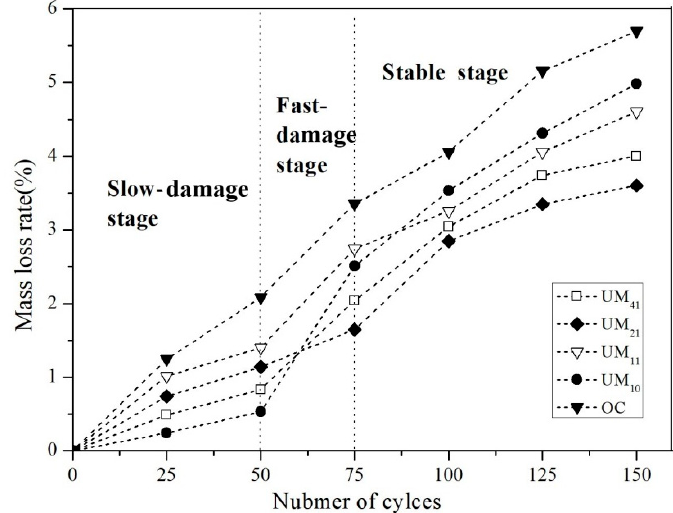
Figure 4. Change in mass loss rates (MLRs) of respective concretes with increasing number of freezing and thawing cycles .